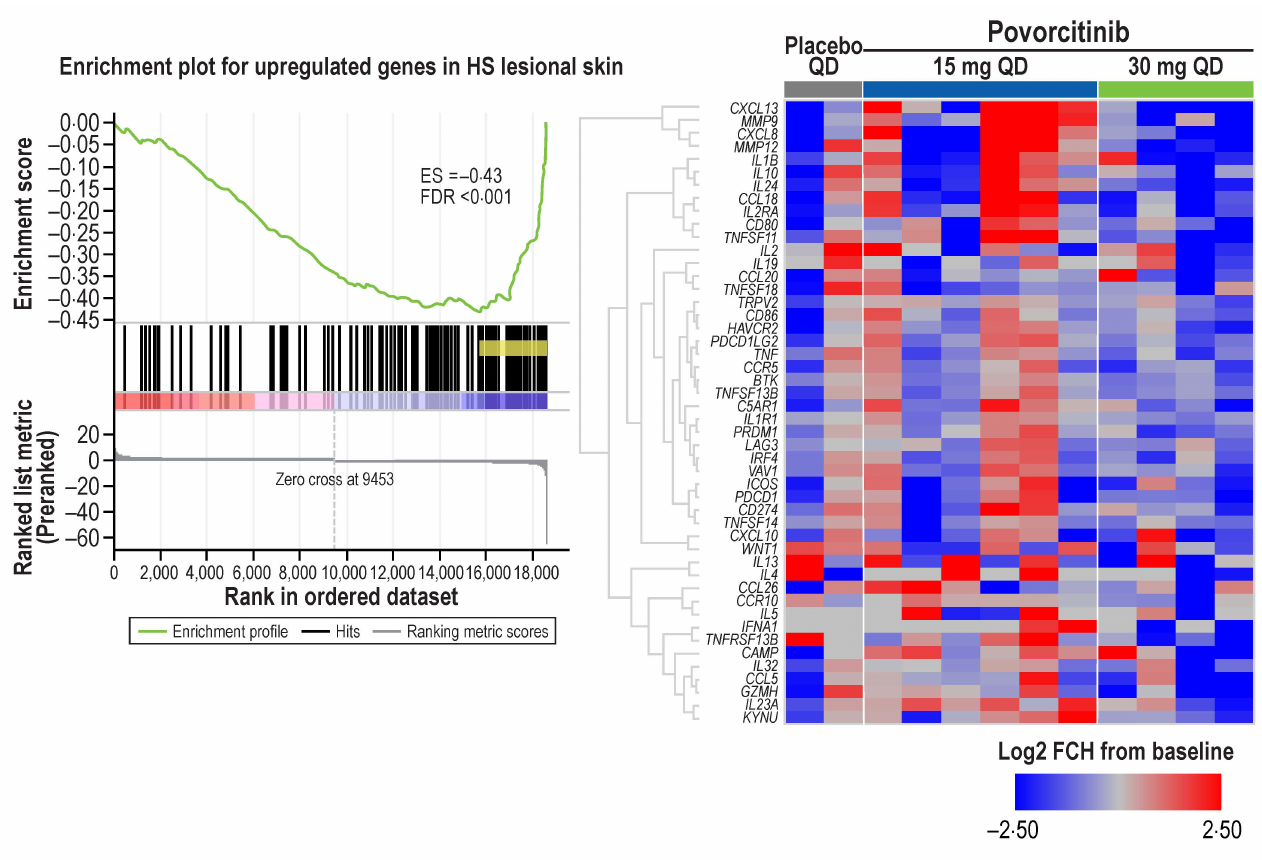
Figure 3. GSEA and enrichment plot showing signature reversal of upregulated genes in HS lesional skin after 8 weeks of treatment with 30 mg povorcitinib QD. * ES, enrichment score; FCH, fold change; FDR, false discovery rate; GSEA, gene set enrichment analysis; HS, hidradenitis suppurativa; QD, once daily. * Plot represents a case (30 mg povorcitinib QD treatment) and GSEA data based on previously described HS gene signature (HS-high) [9]. Genes displayed in heatmap are marked in yellow in the corresponding GSEA